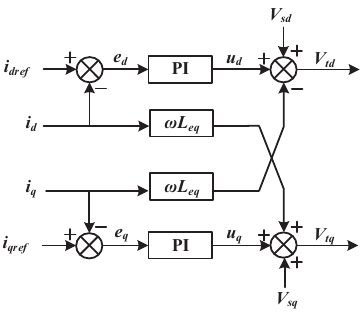
Figure 6. The current controller of MMC based on PI